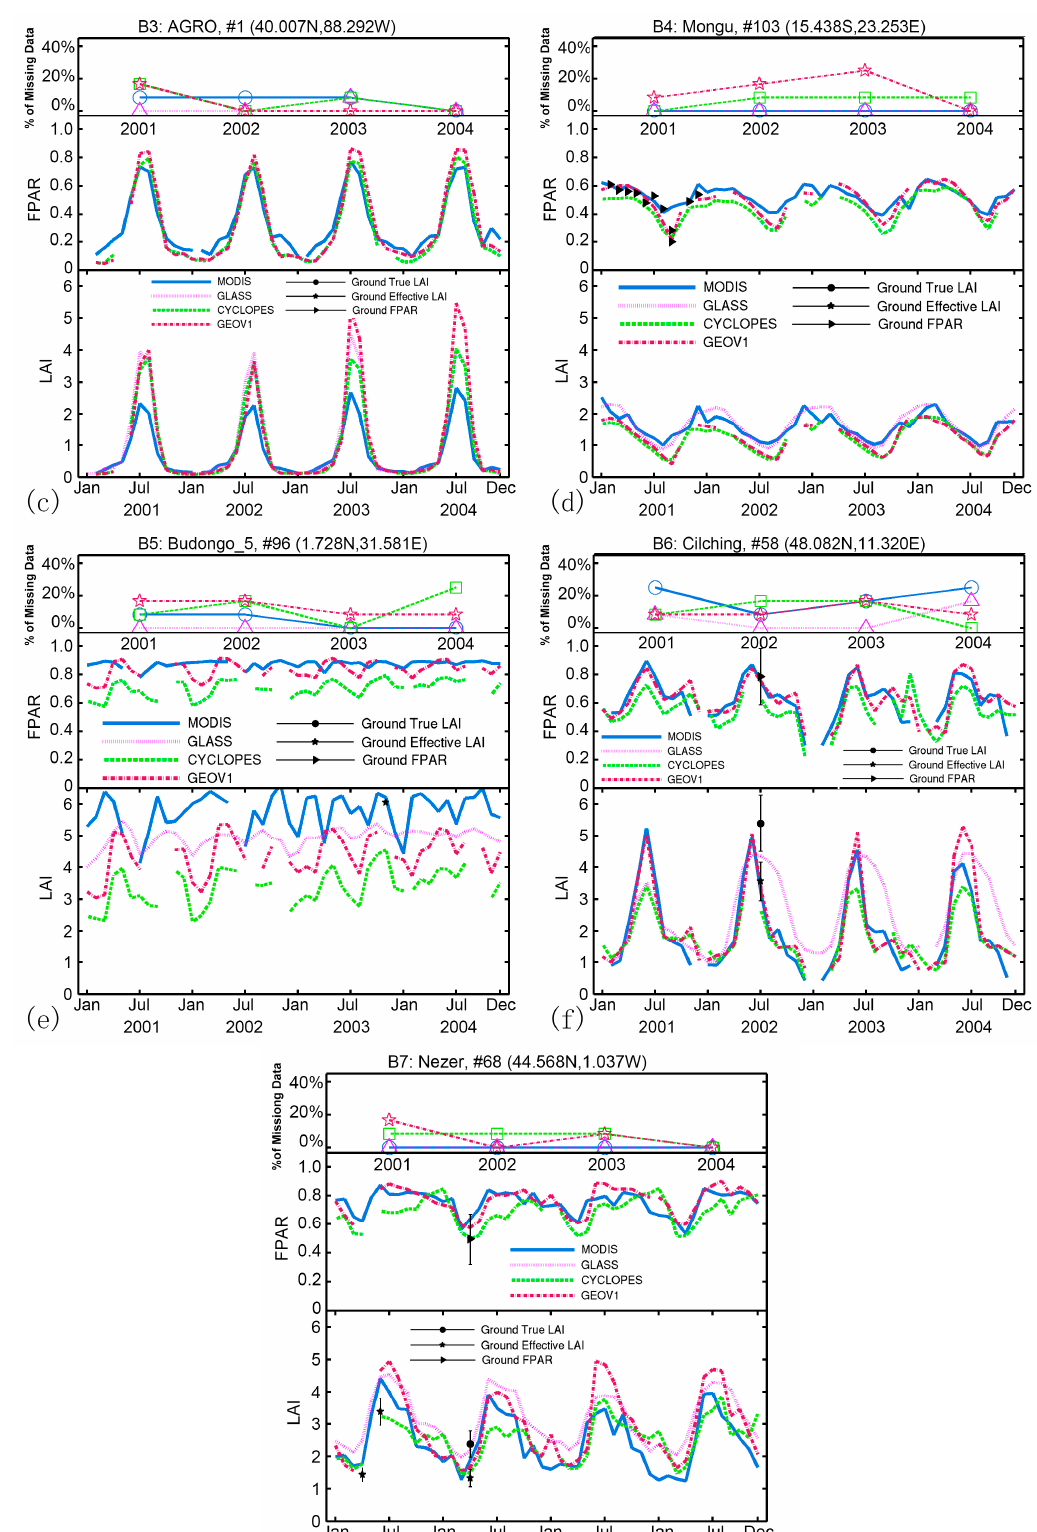
Figure 7. Temporal comparisons of LAI and FPAR among MODIS C6, GLASS, CYCLOPES and GEOV1 products over seven validation sites. Monthly averaged LAI and FAPR values for the time period from 2001–2004 are shown here. Circles, stars and triangles represent ground measurements of true LAI, effective LAI and FPAR, respectively. The four lines plotted at the top represent variations in missing data in each year. ( a ) Grasses; ( b ) shrubs; ( c ) broadleaf crops; ( d ) savanna; ( e ) EBF; ( f ) DBF; and ( g ) ENF.